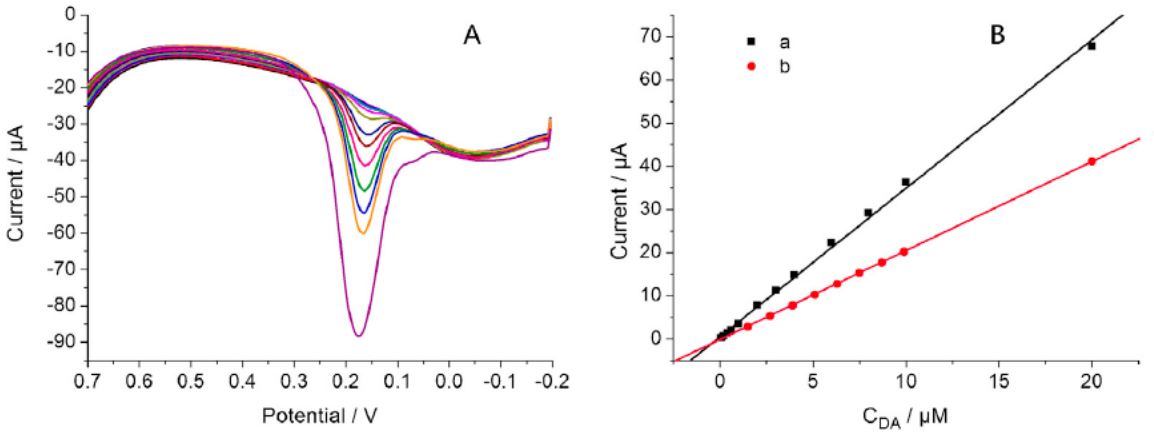
Figure 16. ( A ) The DPVs of increasing DA concentration in 0.1 MPBS (pH = 6.5), DA concentration was 0.05, 0.1, 0.2, 0.4, 0.6, 1, 2, 3, 4, 6, 8, 10, and 20 μ M (from top to bottom), respectively; ( B ) The calibration curve of DA obtained with (a) AuNPs@PS/RGO, and (b) PS/RGO modified GCE. This image was published in Colloids and